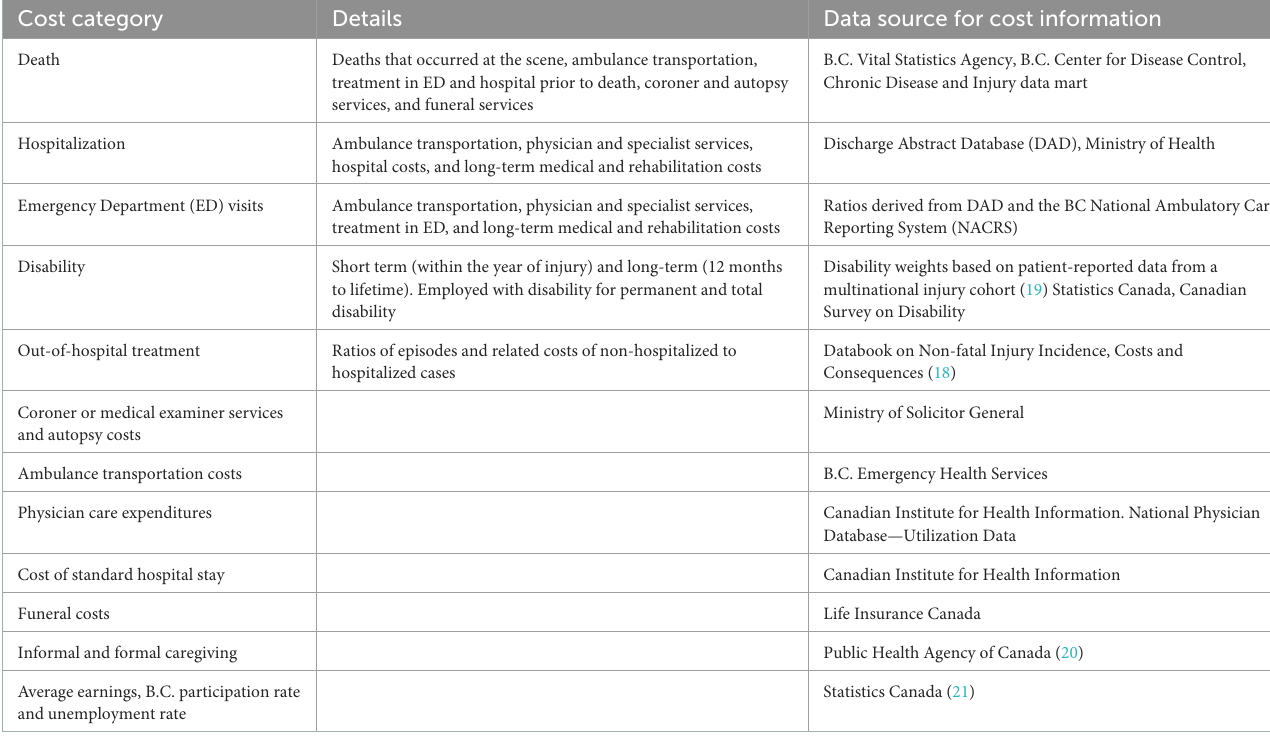
TABLE 1 Data sources for human